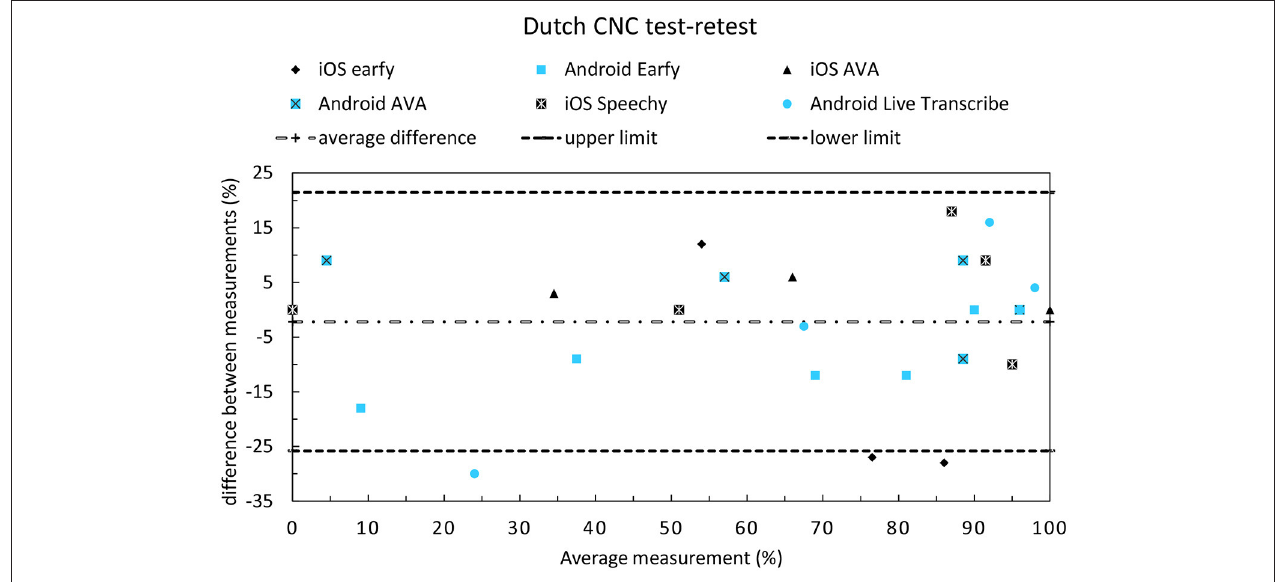
FIGURE 6 | Bland-Altman plot to display the test-retest reliability of the